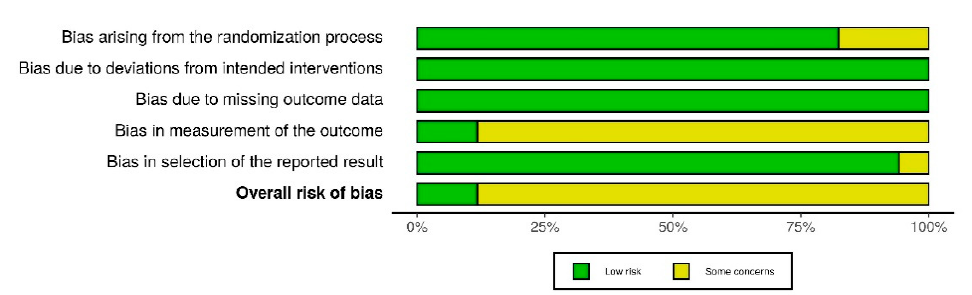
Figure 3. Risk of bias summary plot.